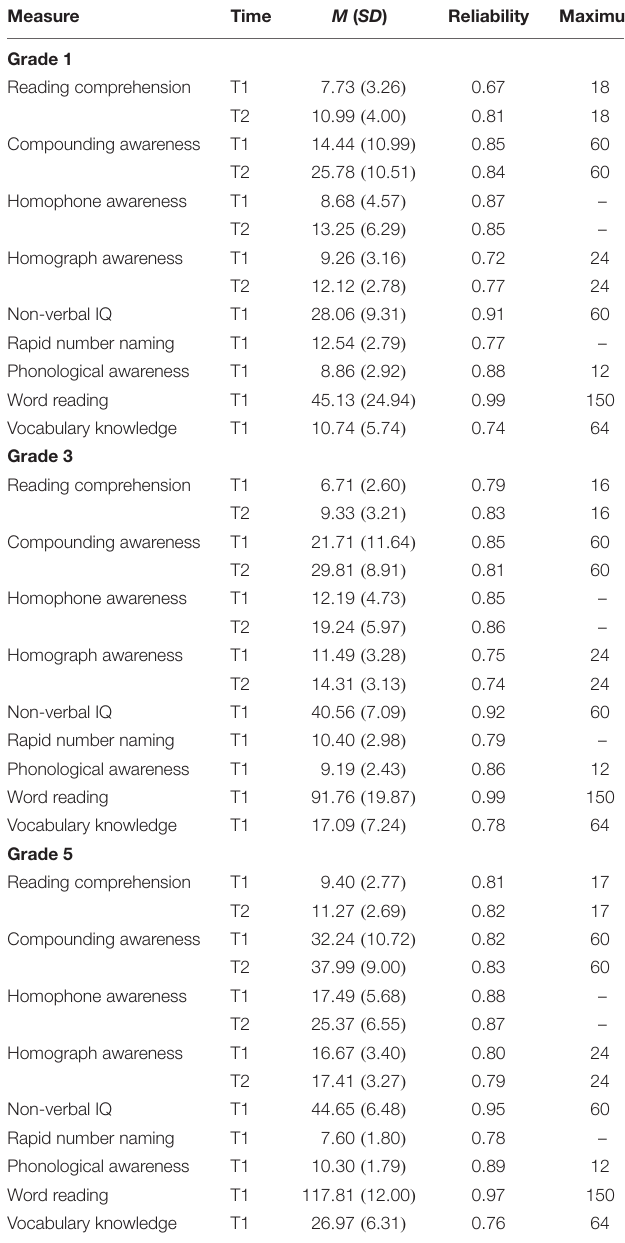
TABLE 1 | Descriptive statistics of all variables among Grade 1, Grade 3, and Grade 5.